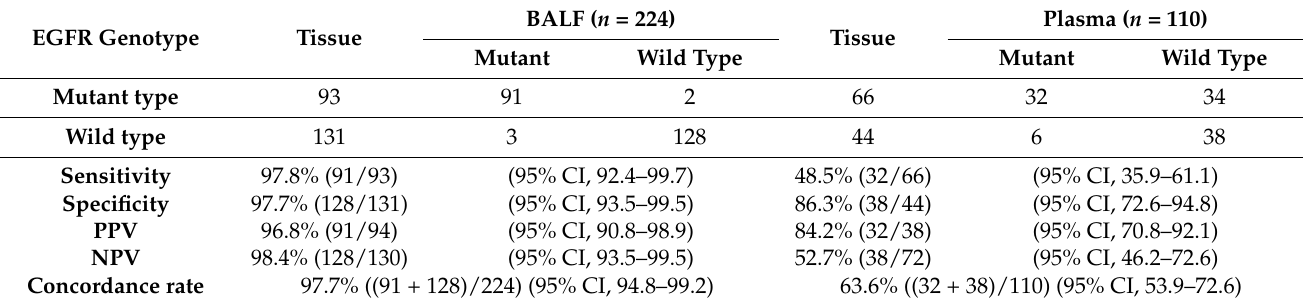
Table 3. Comparison of EGFR mutation detection rate in liquid biopsy between BALF and plasma.